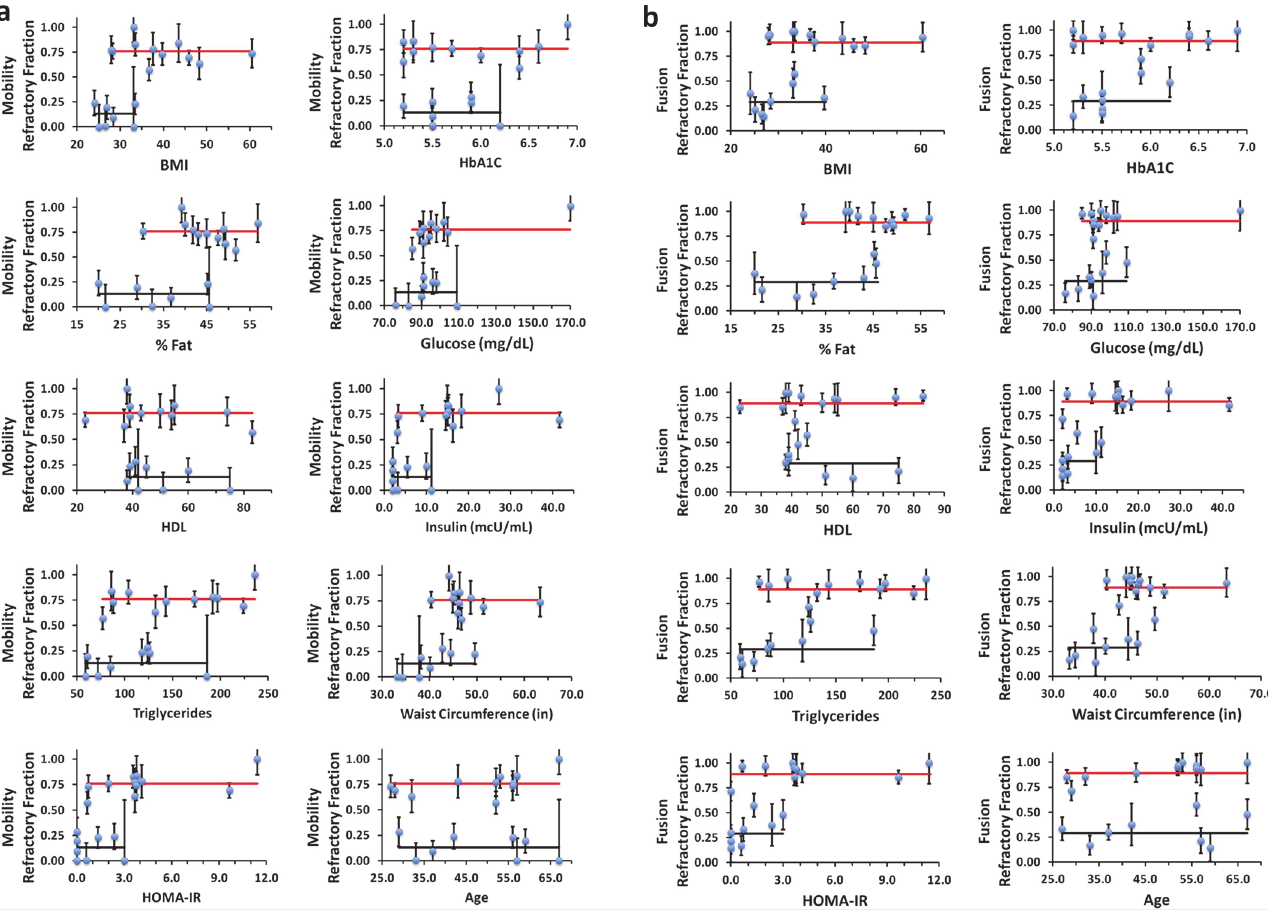
Fig 10. The refractory fractions obtained from analysis of mobility (a) and fusion (b) data plotted as a function of clinical parameters of the donor subject such as BMI, %Fat, HDL, triglycerides, HOMA-IR, waist circumference, age, HbA1C, glucose, and insulin. Refractory fractions cluster into two populations: high (red) and low (black). The solid lines are the cluster averages drawn to span the range of data. The overlap region along the clinical axis is variable with clinical values: e.g. for age the overlap region spans the entire range, while for parameters such as glucose, insulin, BMI and HOMA-IR the overlap region is